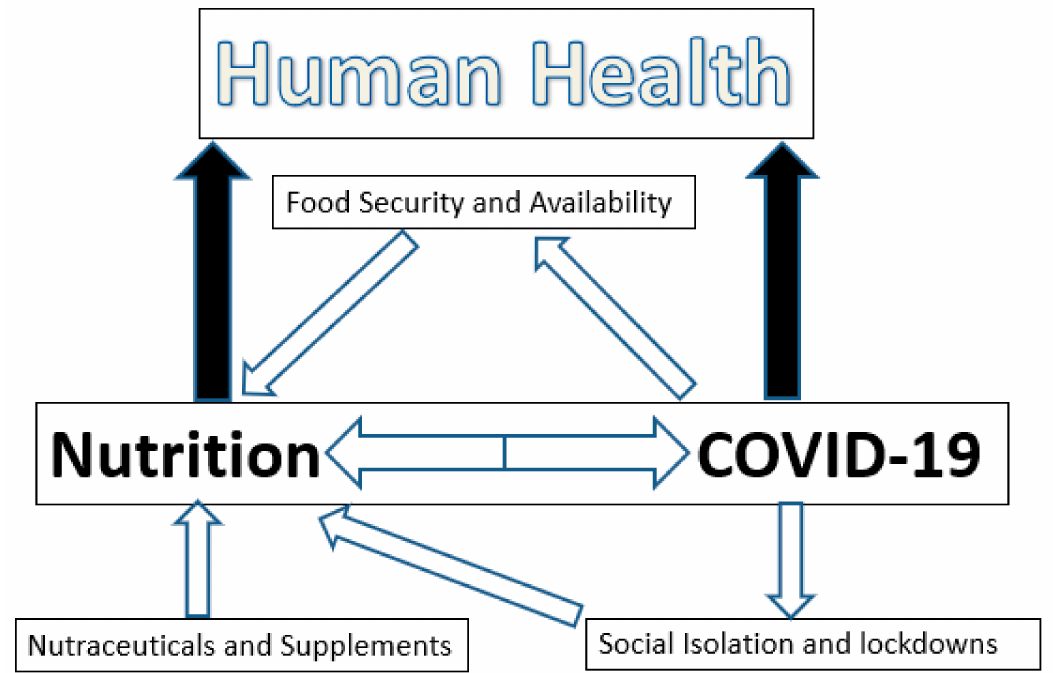
Figure 2. The interactions of nutrition and COVID-19